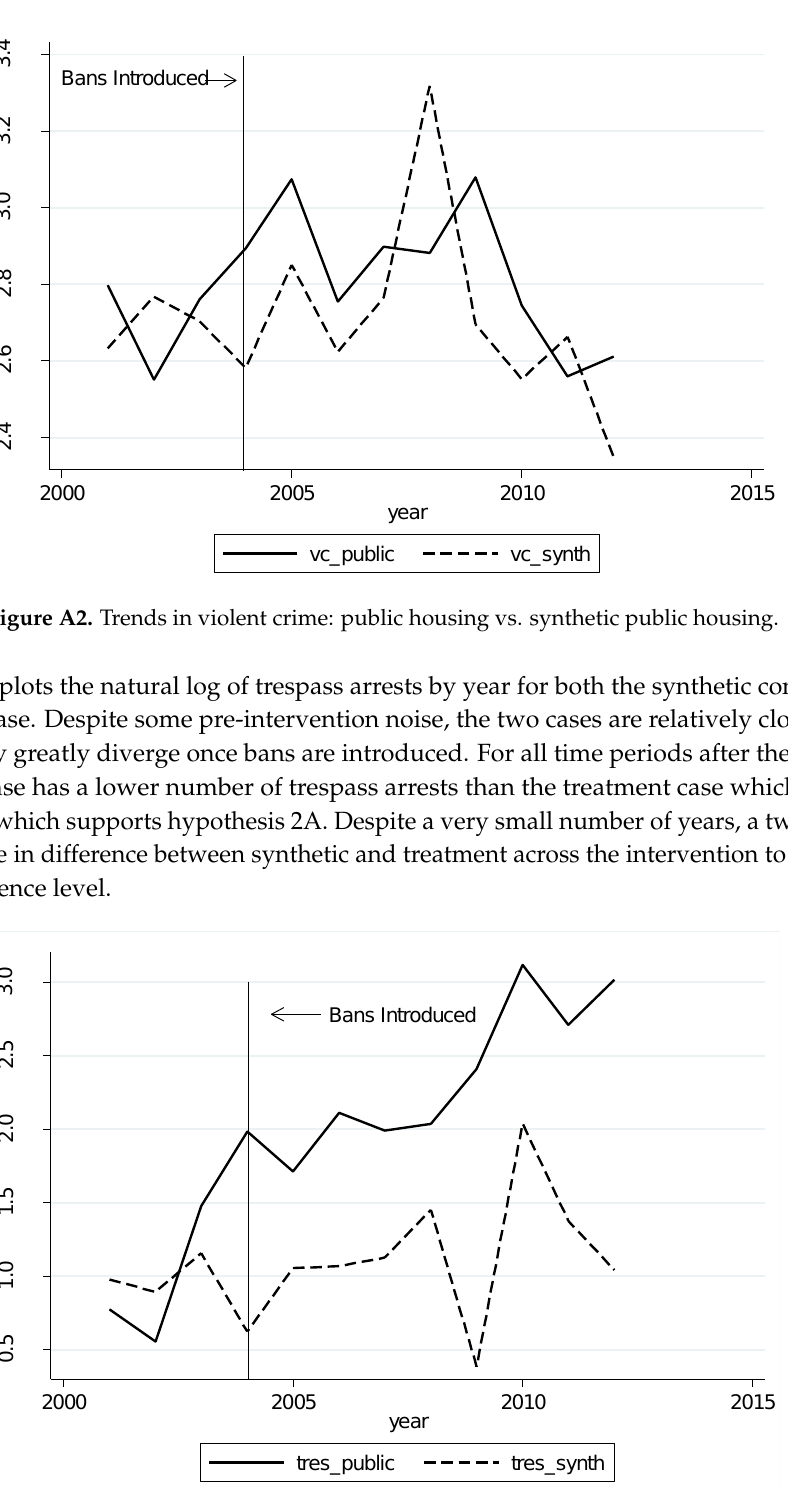
Figure A4. Trends in drug arrests: public housing vs. synthetic public housing.